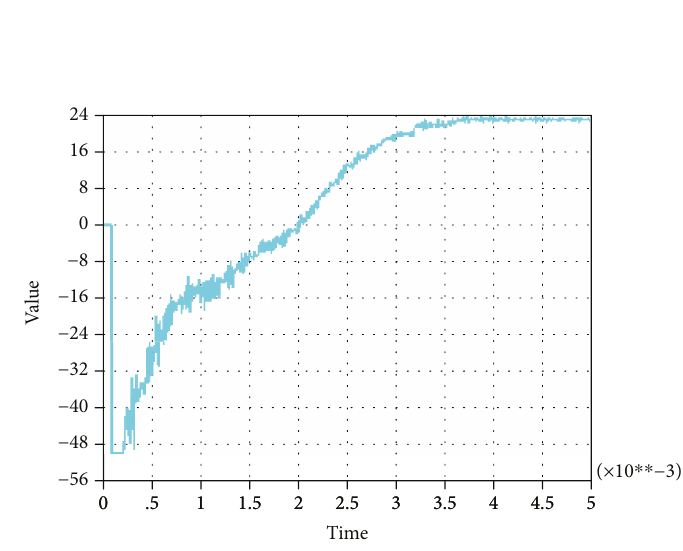
Figure 23: VY velocity